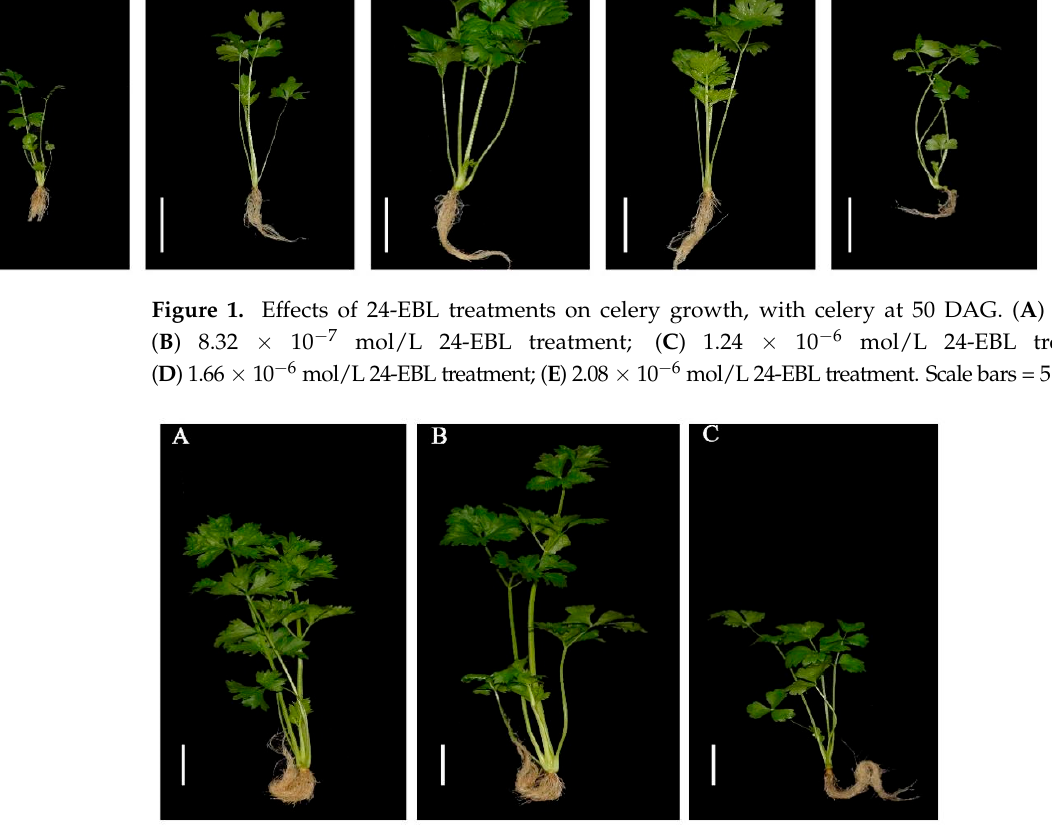
Figure 2. Effects of 24-EBL and PCZ + 24-EBL treatments on celery growth, with celery at 60 DAG. ( A ) Control; ( B ) 1.24 × 10 − 6 mol/L 24-EBL treatment; ( C ) 1.24 × 10 − 6 mol/L 24-EBL + 2.90 × 10 − 3 mol/L PCZ treatment. Scale bars = 5 cm.